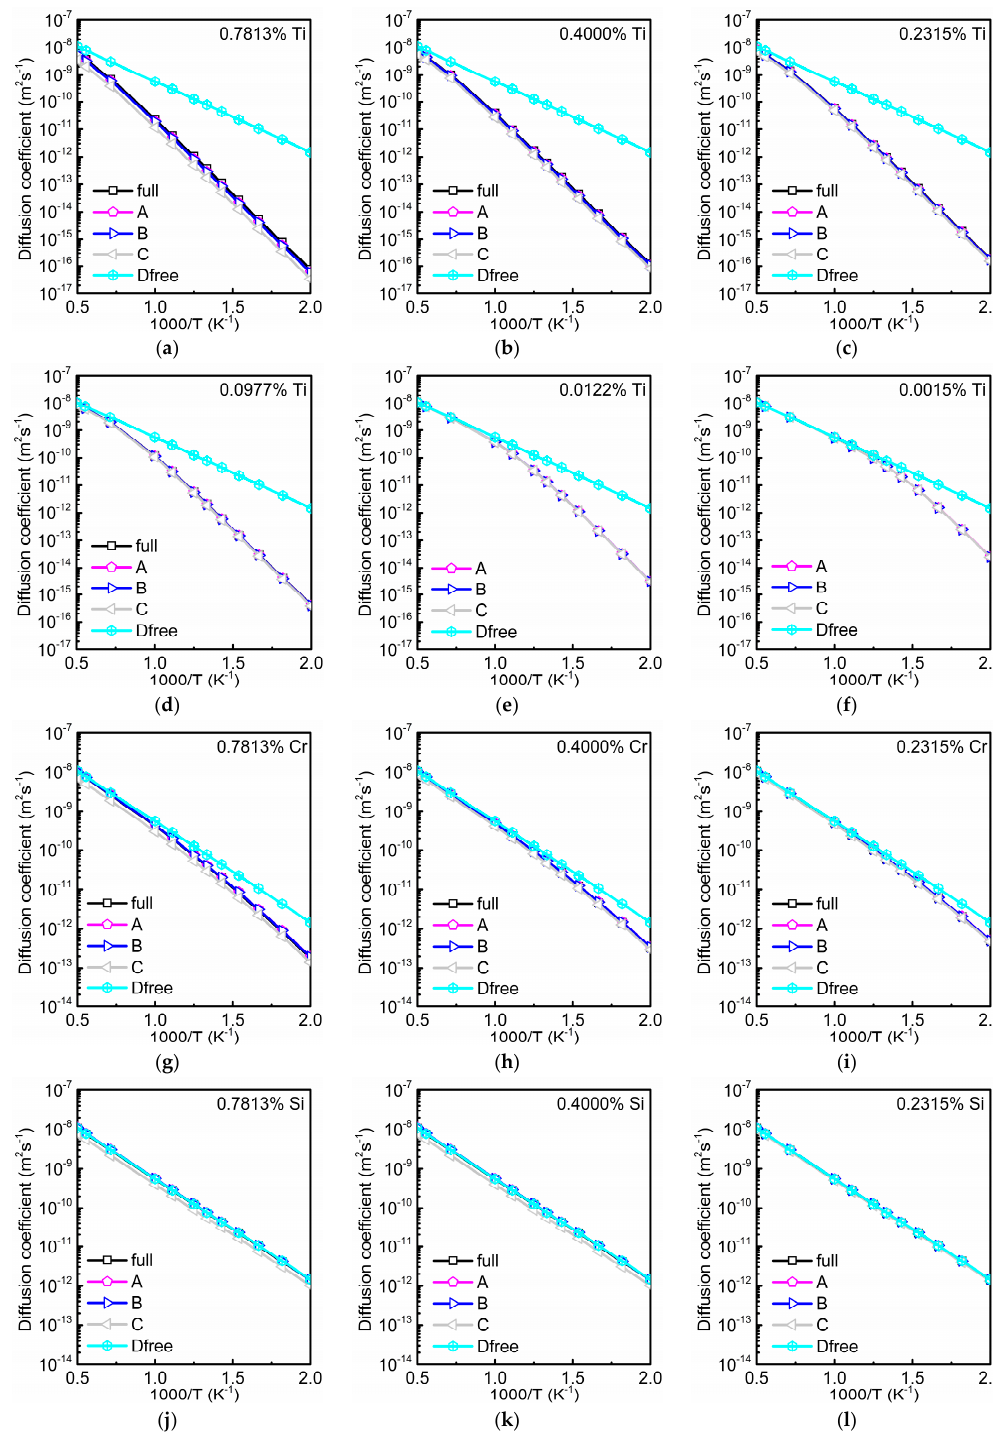
Figure 6. Total di ff usion coe ffi cient D of oxygen in dependence on temperature and solute concentration obtained by di ff erent calculation methods. Curves marked by ‘full’ show results from full atomistic kinetic Monte Carlo (AKMC) simulations [2]. ‘A’ denotes the data determined by Equations (1) and (2) with the time ratios and D inter from AKMC simulations for the respective concentrations c S . Data determined by Equations (1)–(3) with D inter from AKMC simulations are marked by ‘B’, while results from Equation (4) with t free / t total from Equation (3) are denoted by ‘C’. The di ff usion coe ffi cient of oxygen in pure bcc Fe ( D free ) is plotted as reference. For Cr or Si below 0.2315% the di ff erence between D and D free is very small. Therefore, these data are not shown. Results for Ti ( a – f ), for Cr ( g – i ), and for Si ( j – l